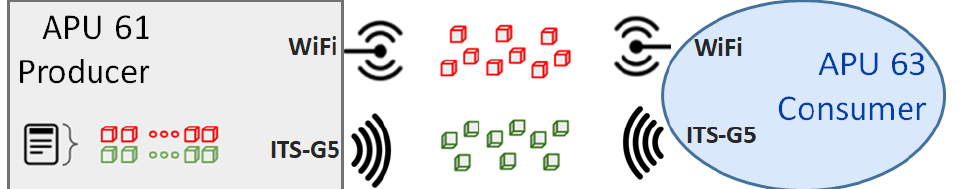
Figure 10. NDN in multiple wireless interfaces—requesting a 6 MB file using both ITS-G5 and Wi-Fi.